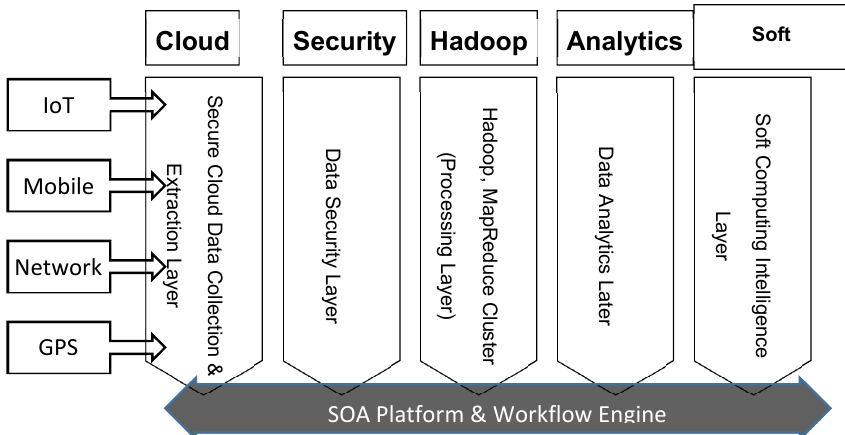
Figure 5. SOA-Based Soft Compute approach for BIMA framework (SoftBD).